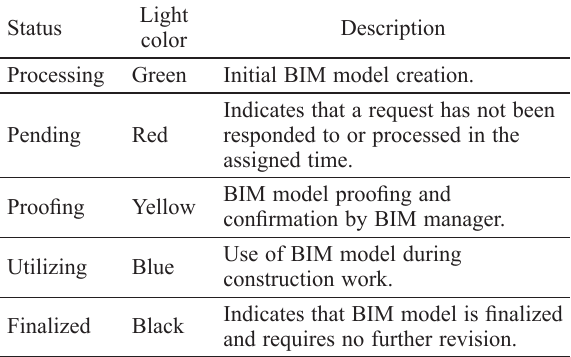
Table 2. Description of each process status of BIM